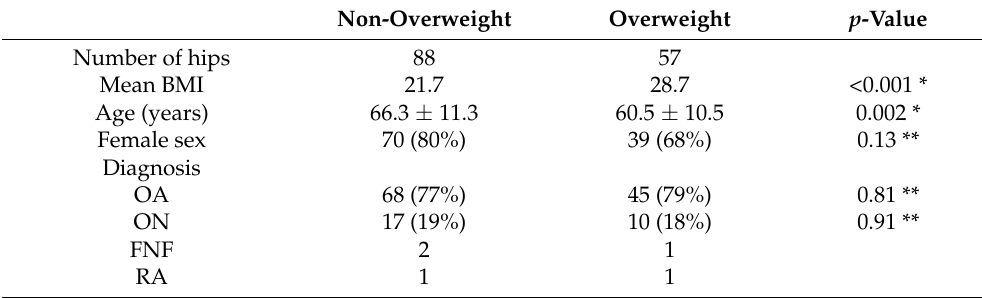
Table 1. Patients’ demographic characteristics.